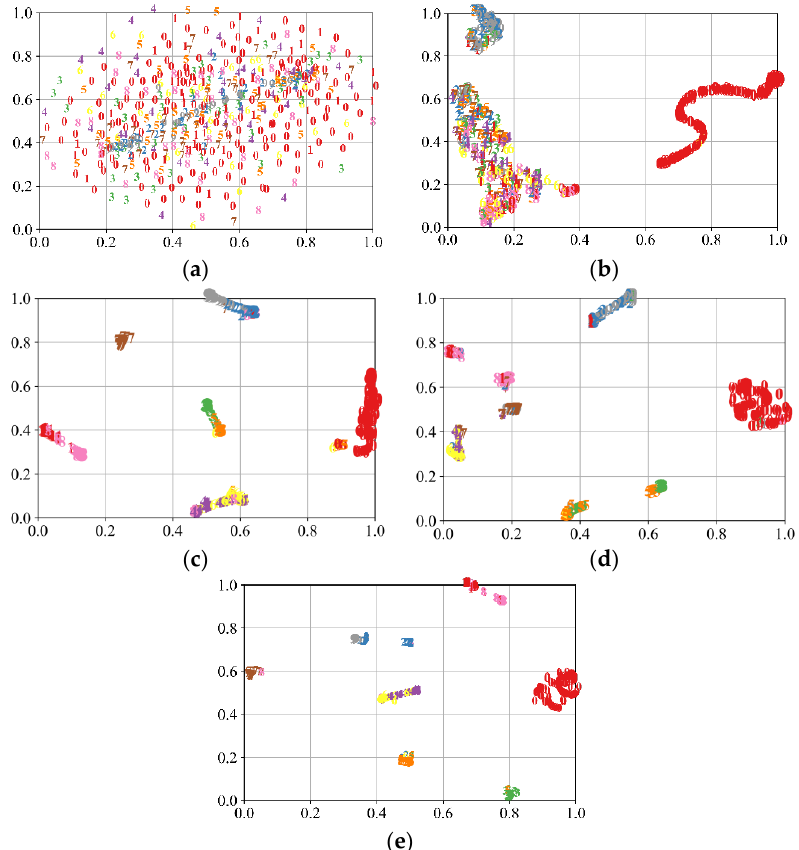
Figure 9. ( a ) Visualization of Raw dataset; ( b ) Visualization of CNN model dataset; ( c ) Visualization of DRSN model dataset; ( d ) Visualization of the dataset of ACGAN+CNN; ( e ) Visualization of the dataset of ACGAN+DRSN .